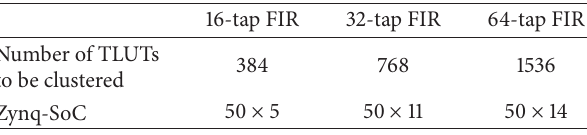
Table 1: Dimensions for the placement